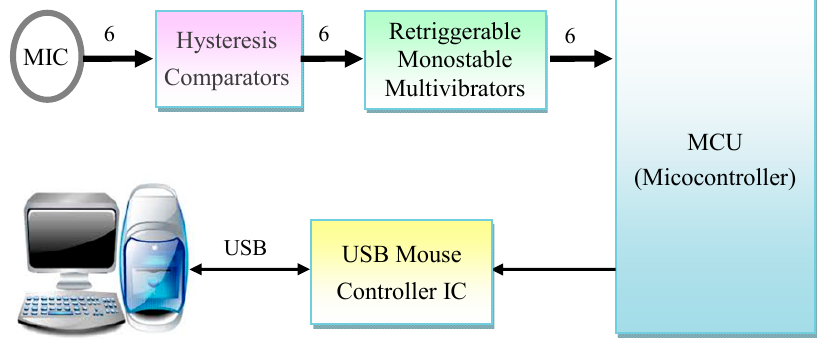
Figure 2. The architecture of the proposed blowing-controlled mouse.